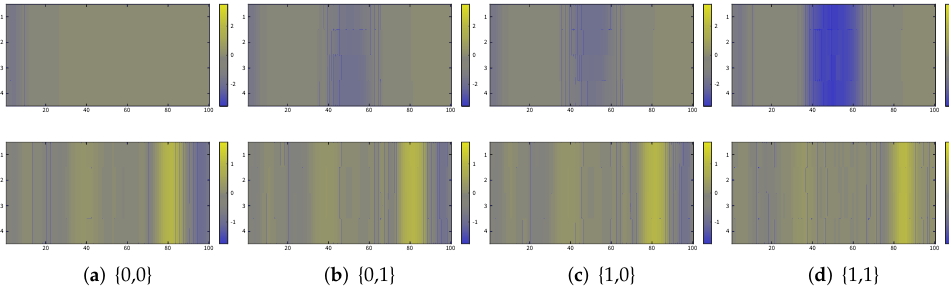
Figure 13. Example of the NAND gate topology for each possible input { x , y } . Voltage ( V ) across capacitors C of each M - RLC circuit on the input ( t 1 ) frame ( top ) and the result ( t 3 ) frame ( bottom